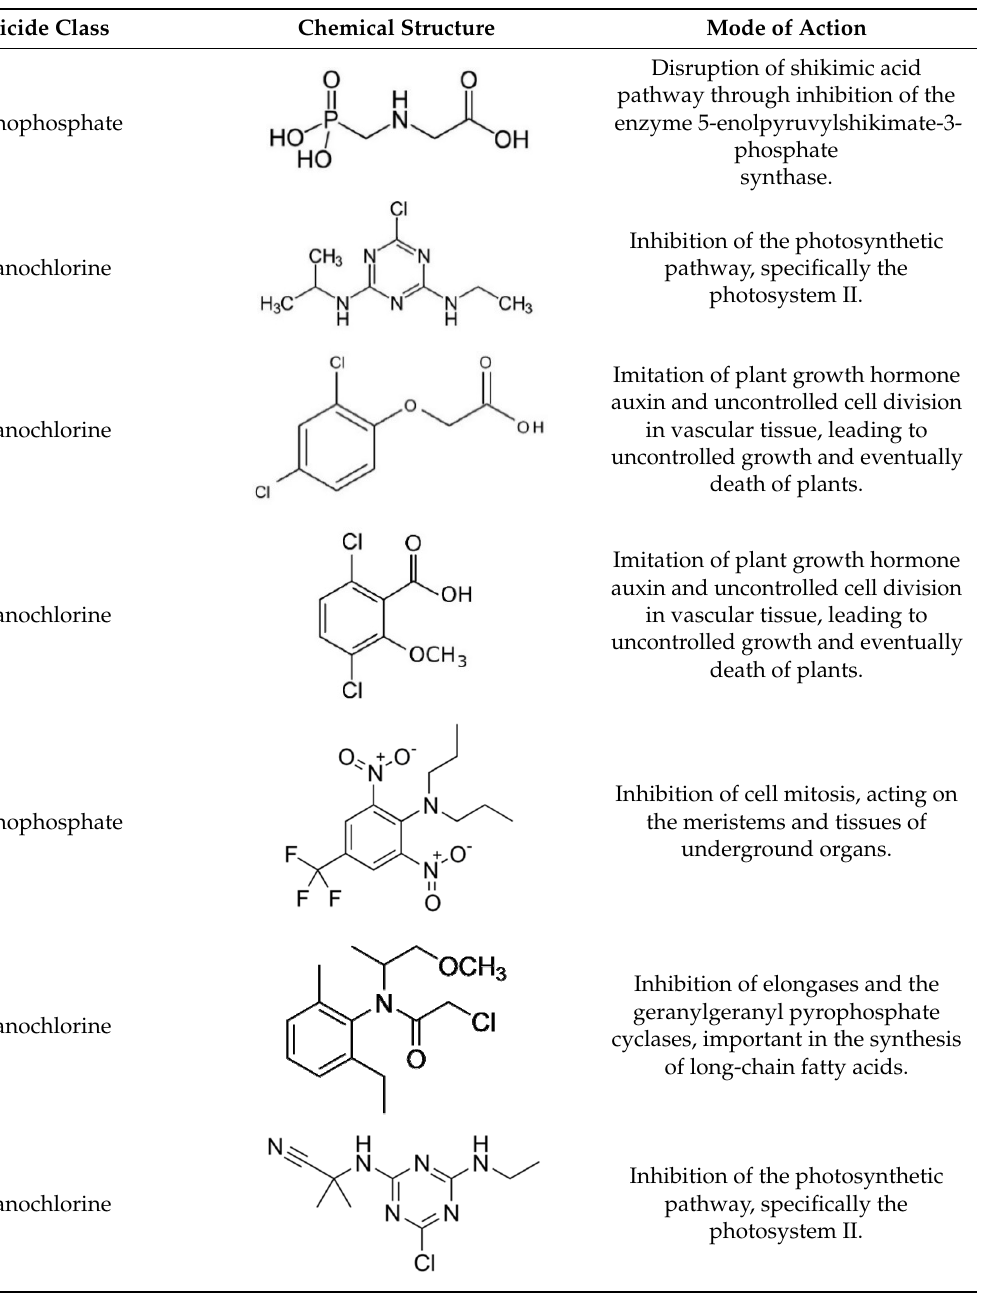
Table 4. Classification of the most common herbicides used in agricultural soil.